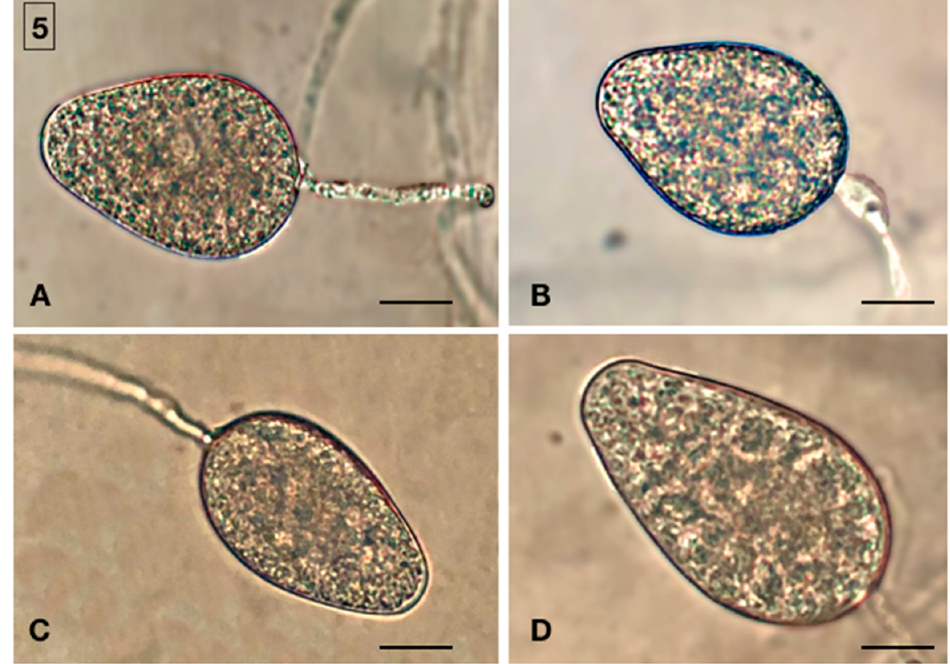
Figure 5. Sporangia of Phytophthora × cambivora and P. gonapodyides . ( A , B ) Non-papillate, persistent, and ovoid sporangia of P. × cambivora ( C , D ). Non-papillate, persistent, and ellipsoid sporangia of P. gonapodyides . Scale bar: 25 µm.